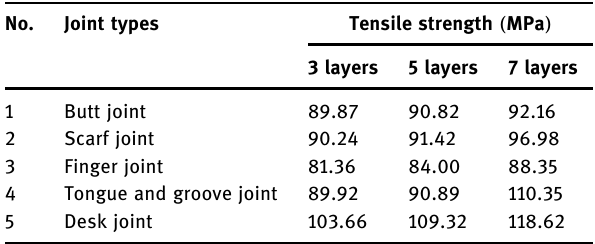
Table 4: Tensile test results of di ff erent joint types